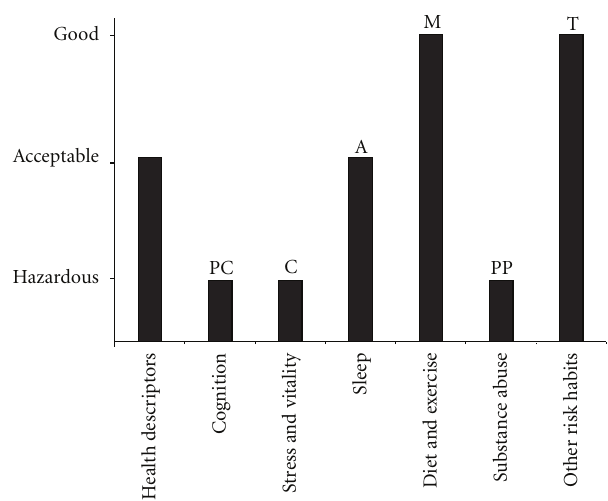
Figure 1: Sample lifestyle profile based on eVITAL toolkit. Prochaska stages: precontemplation (P), contemplation (C), prepa- ration (PP), action (A), maintenance (M), termination